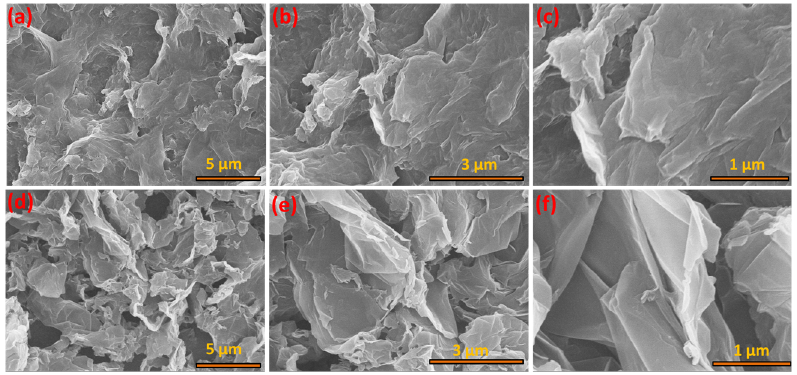
Figure 2. SEM images of GO ( a – c ) and S@rGO ( d – f ).